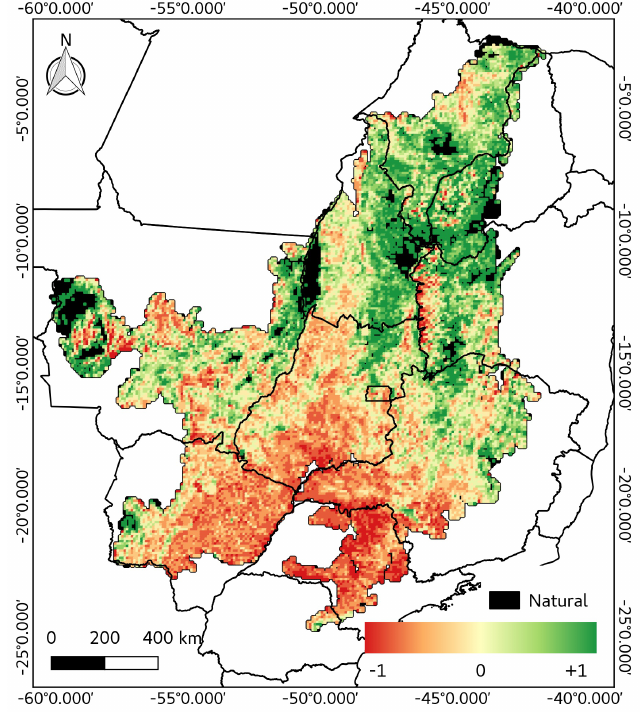
Figure 4. Gridded Land Sharing/Sparing Index for the Cerrado. Negative values (red) indicates more land sparing-oriented landscape and positive values (green) indicates more land sharing-oriented